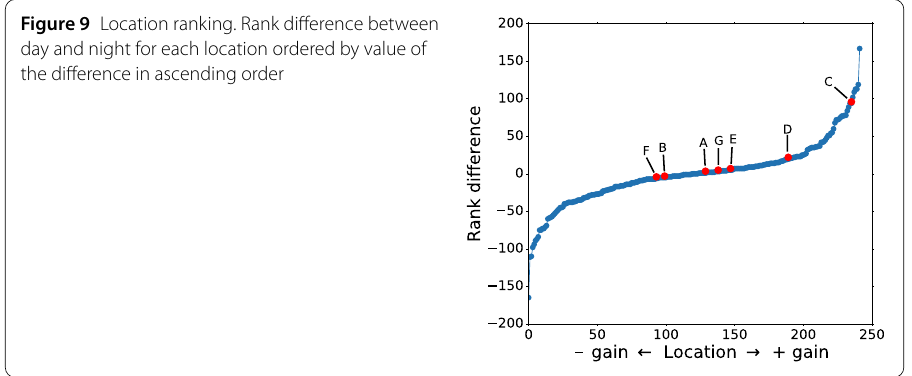
Figure 9 Location ranking. Rank difference between day and night for each location ordered by value of the difference in ascending